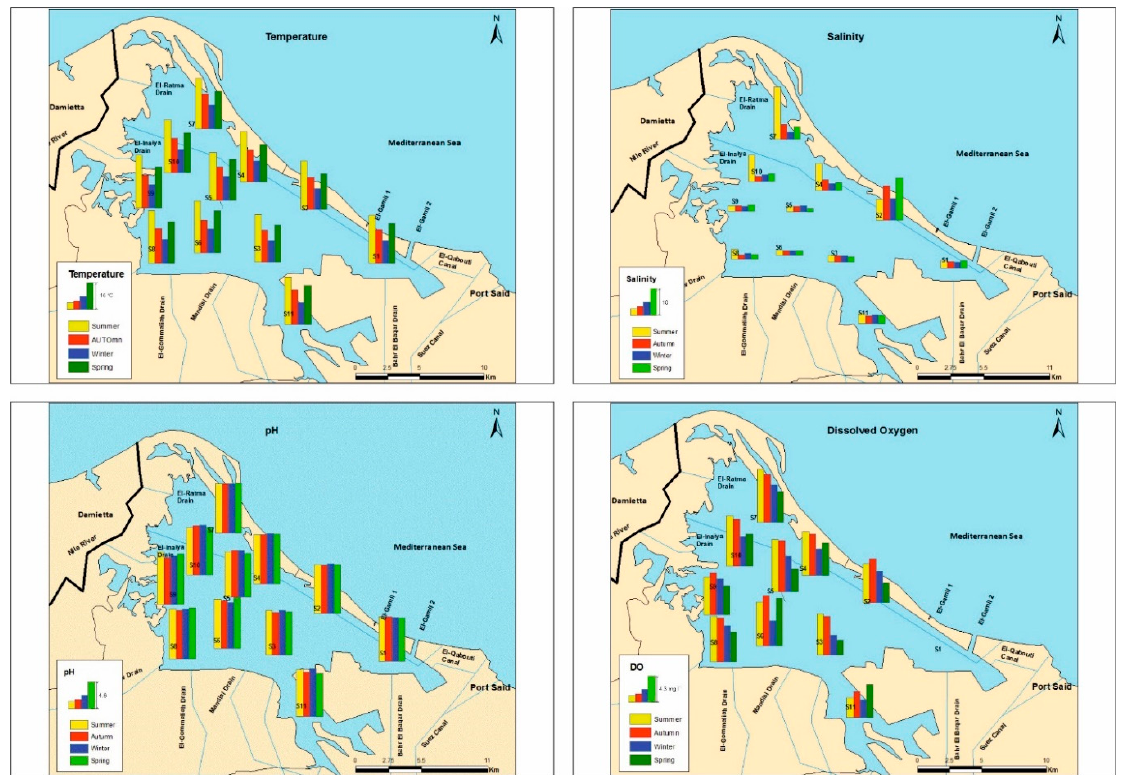
Figure 2. Spatiotemporal variations of physicochemical variables in Lake Manzalah.